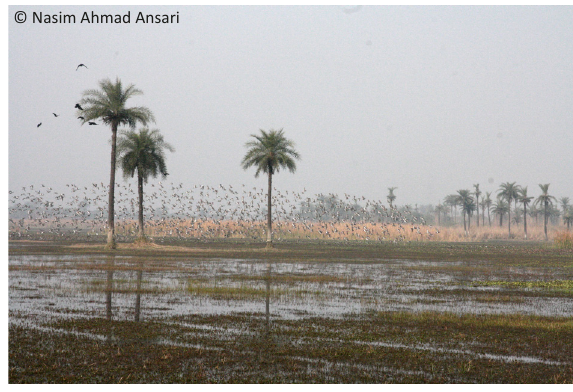
Image 3. Overview of Surajpur Wetland - winter